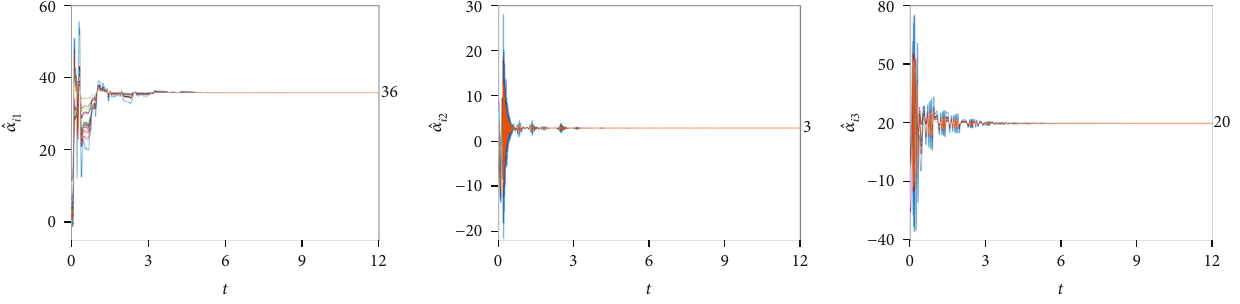
Figure 4: Partial ampli fi cation of synchronization errors e